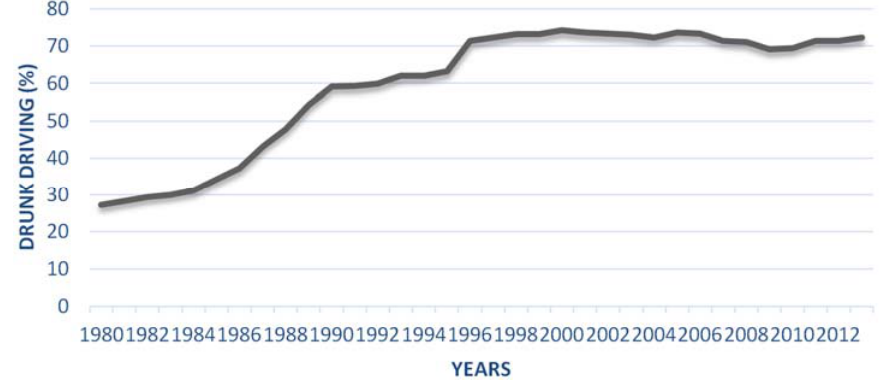
Fig. 2. Percentage of drunk driving in South Africa